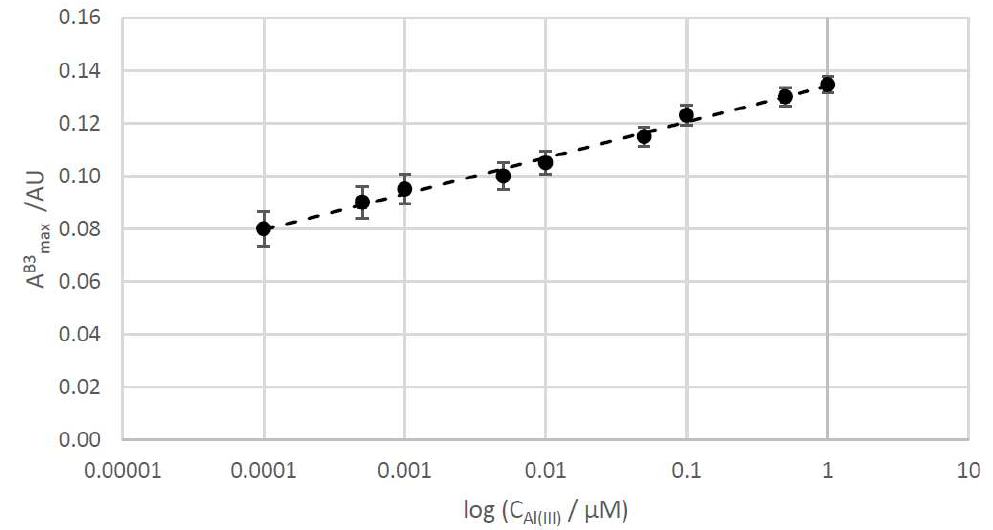
Figure 6. Calibration line of the A B3 max versus di ff erent concentrations of aluminum. Limits of detection (LOD) and limit of quantitation (LOQ) were estimated to evaluate the sensitivity of silver nanoparticles to detect low amounts of metal in solution. LOD and LOQ were calculated as the concentration of Al(III), producing a signal (maximal absorbance) equal to 3 and 10 times the standard deviation of the blank signal, respectively [42]. In this case, maximal absorbance, corresponding to B1 ( A B1 ) in the spectra of the mixture containing lower amounts of Al(III) (10 M), was considered the blank signal [43]. The obtained values for LOD and LOQ were 4.05 × 10 and 13.5 ·× 10 M Al(III), respectively. These values indicate that citrate + PVP-AgNPs can be used as sensor for detecting the presence of Al(III) in solution with high